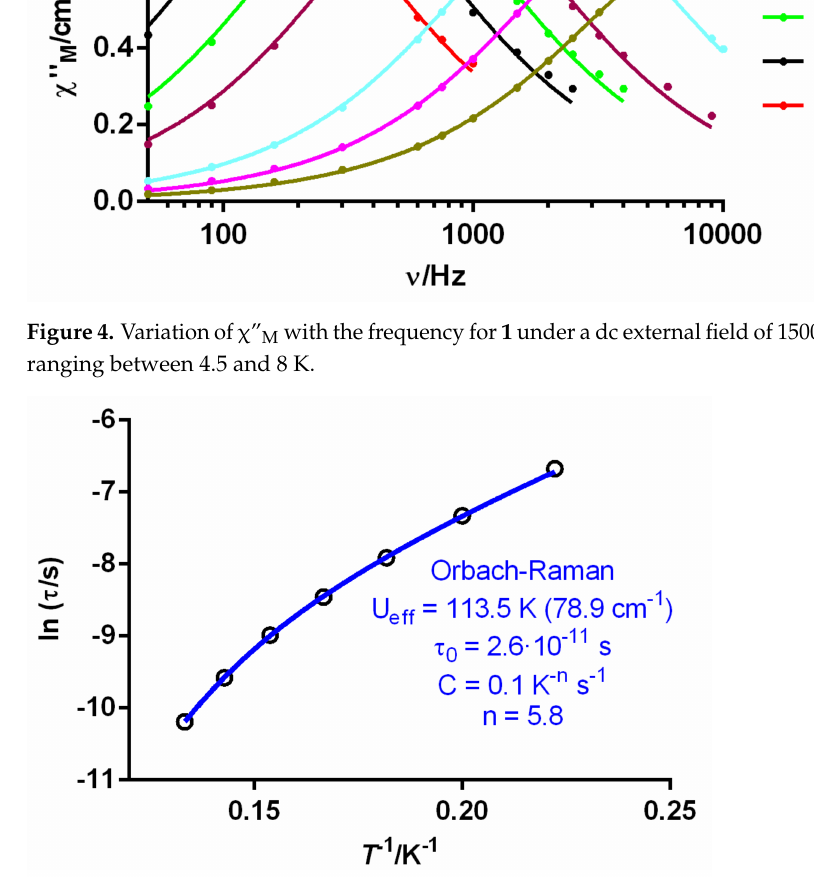
Figure 5. Arrhenius graph for 1 under an external dc applied field of 1500 Oe. The blue line represents the best fit, taking into account Orbach plus the Raman relaxation processes (Equation